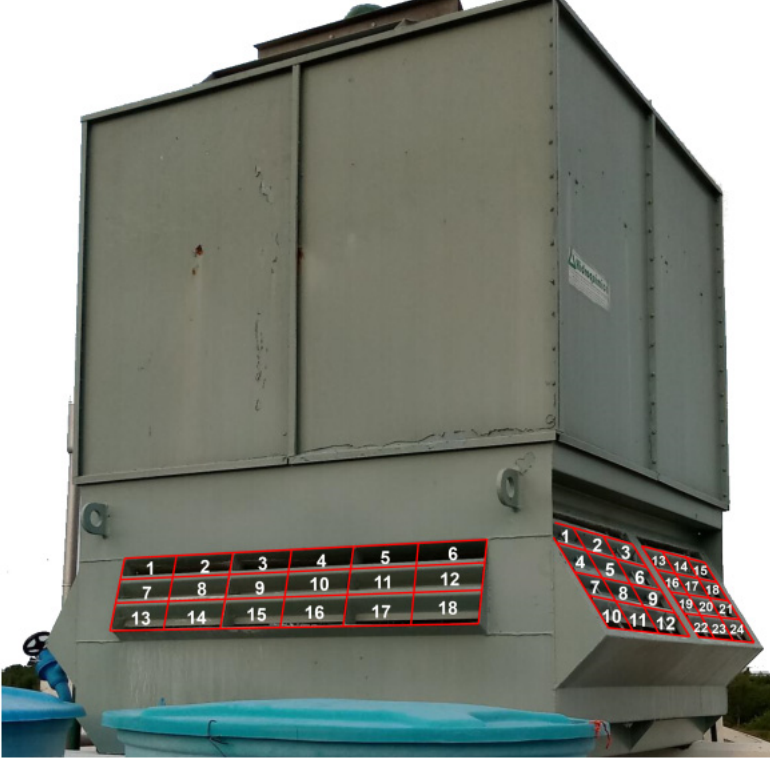
Figure 2. Divisions of the air intakes of the industrial refrigeration unit of the evaporative condenser for the measurements of the inlet velocity.